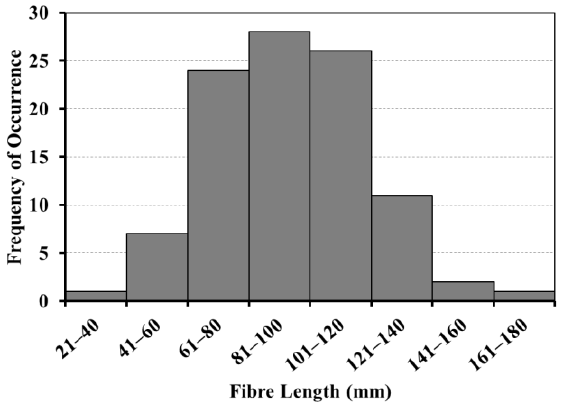
Figure 4. Histogram of measured lengths of flax technical fibres.